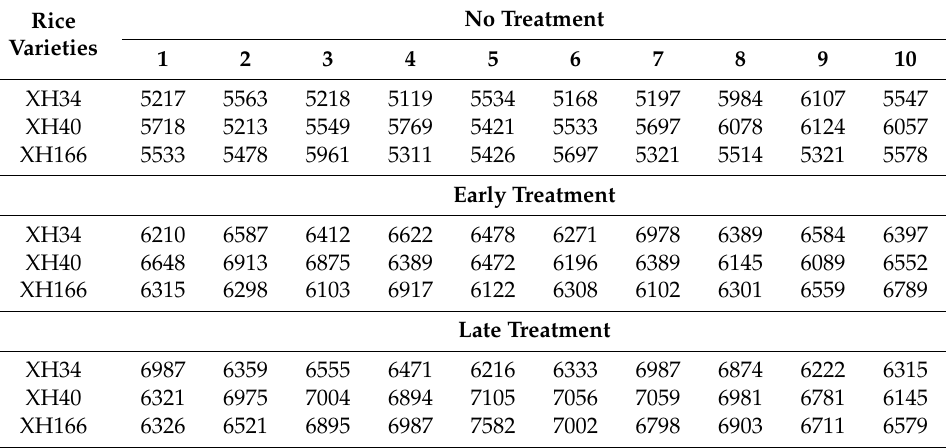
Table 6. Count of rice panicles for di ff erent types of